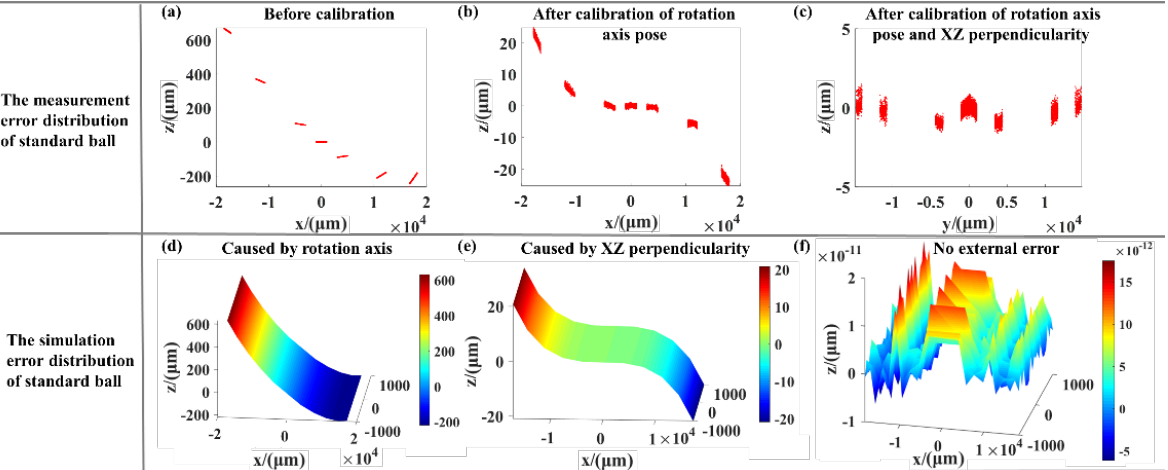
Figure 10. The distribution of error in the measurement data: ( a ) Before calibration of the pose of the rotation axis and the XZ perpendicularity; ( b ) After the pose of the rotation axis were calibrated; ( c ) After the pose of the rotation axis and the XZ perpendicularity were calibrated; The distribution of error in the simulation data: ( d ) Before calibration of the pose of the rotation axis and the XZ perpendicularity; ( e ) After the pose of the rotation axis were calibrated; ( f ) After the pose of the rotation axis and the XZ perpendicularity were calibrated.